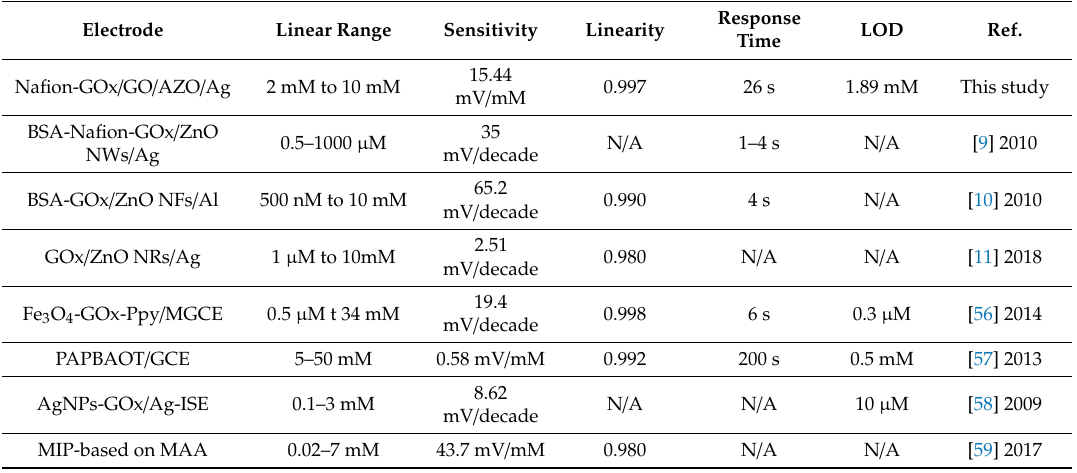
Table 4. Potentiometric glucose biosensors based on di ff erent electrodes [8–10,55–58]. Electrode Linear